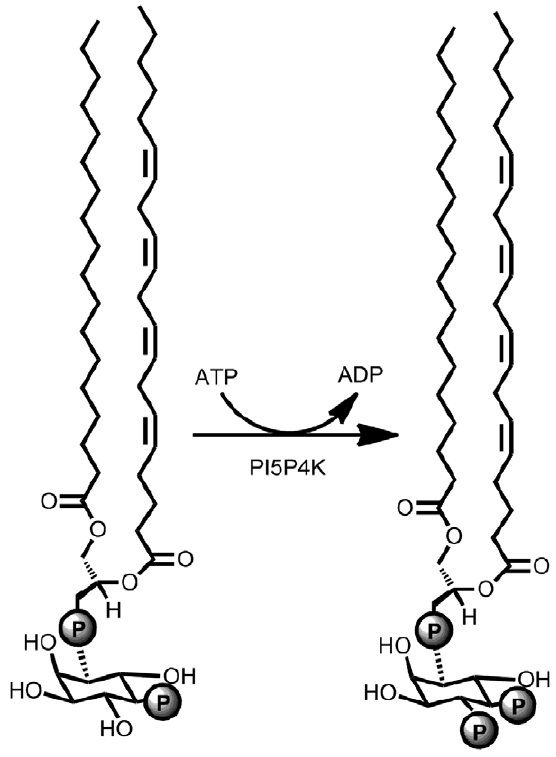
Figure 1. Schematic representation of the PI5P4K reaction using PI5P as the substrate. The additional carrier substrate DPPS is not shown.